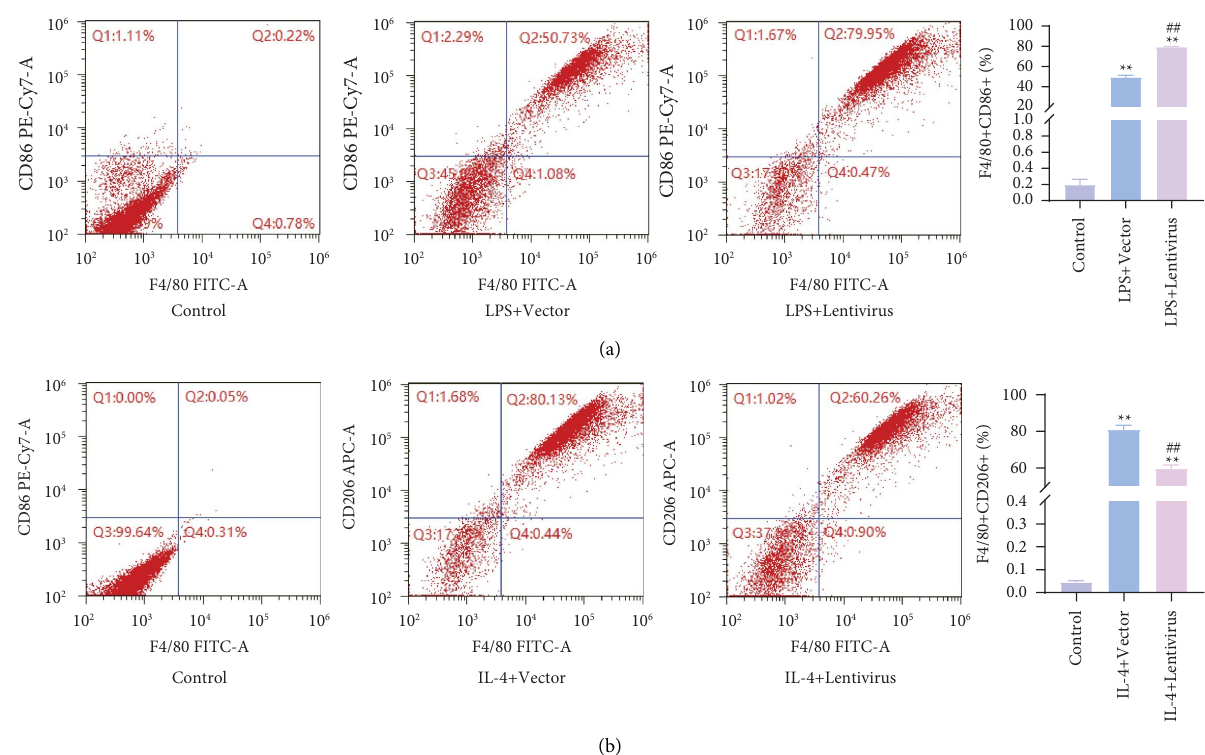
Figure 4: Efect of the PPARG interference on polarization of macrophages ( n � 3). (a) Interference with PPARG promoted LPS-induced polarization of M1 macrophages; (b) interference with PPARG inhibits IL-4 induced polarization of M2 macrophages. ∗∗ P < 0 . 01 vs. Control; ## P < 0 . 01 vs. Model.